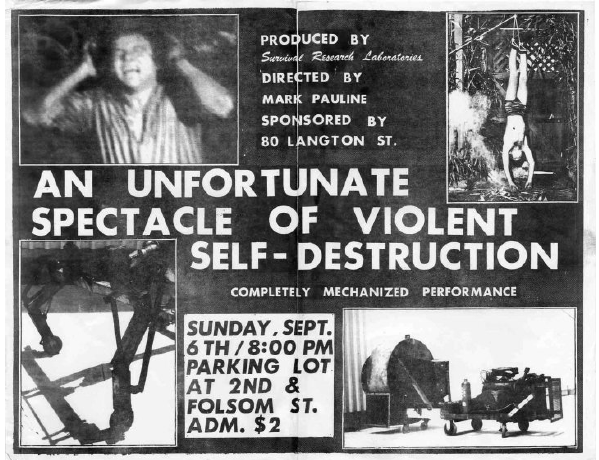
Figure 11. Poster for An Unfortunate Spectacle of Violent Self ‐ Destruction , a mechanical performance by SRL, 6 September 1981, Metro Park parking lot, San Francisco. © Survival Research Labs.